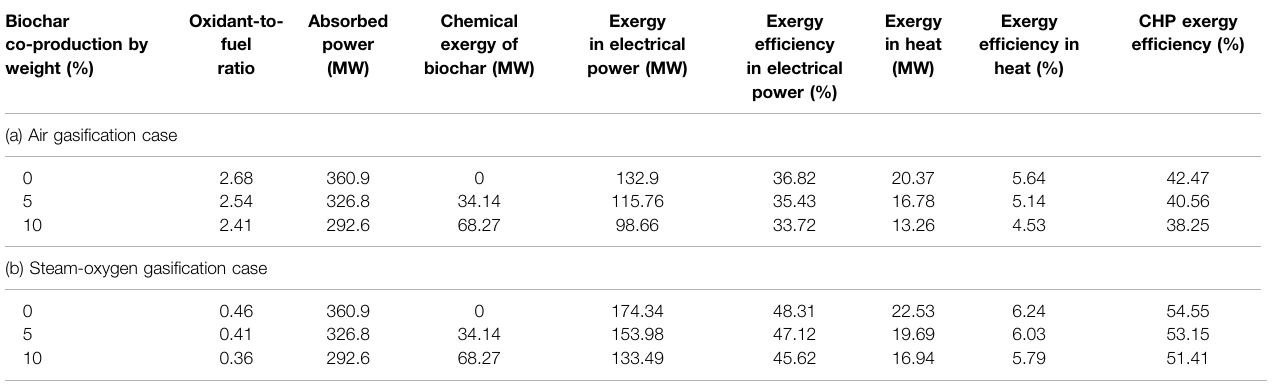
TABLE 9 | Exergy analysis in each gasi fi cation case with respect to the biochar co-production. Biochar Oxidant-to- co-production by fuel weight (%)